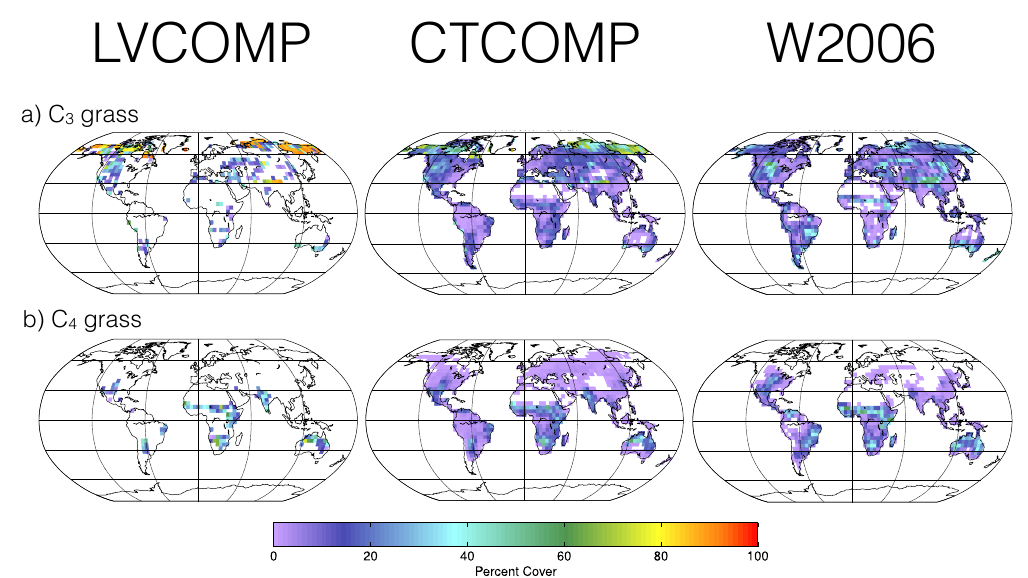
Figure 4. Comparison of simulated fractional coverage of grass PFTs in the LVCOMP (based on the original L–V equations, left column) and CTCOMP (based on modified L–V equations, middle column) simulations with the observation-based estimate from the modified Wang et al. (2006) data set corresponding to year 1861 (right column).